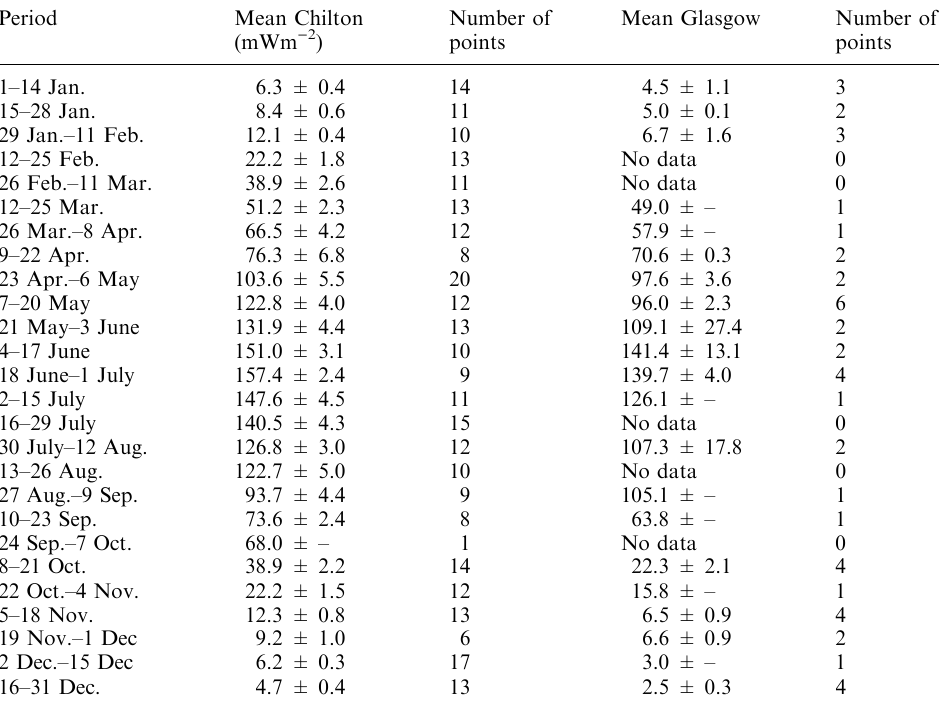
ery Period Mean Chilton